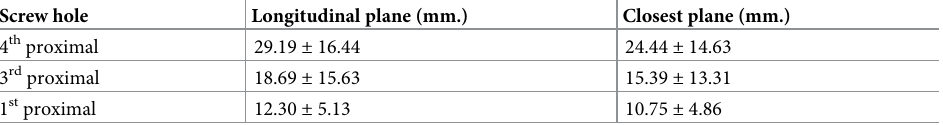
Table 1. The average distances of the ‘risky’ screw holes to the radial nerve and profunda brachii artery in the lon- gitudinal plane and closest plane (Mean ± SD). Screw